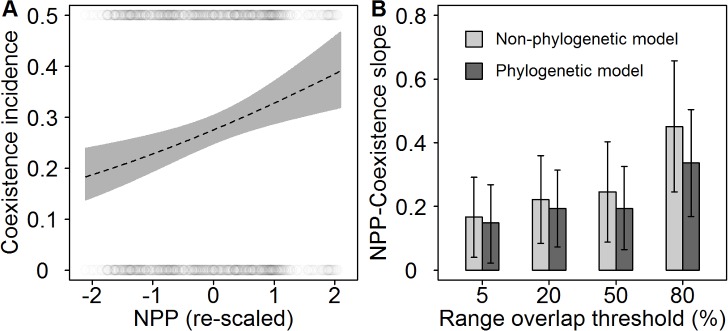
The relationship between (A) coexistence and energy availability (NPP) across sister species pairs is positive and (B) strengthens with the area over which species coexist (as a percentage of the smaller species range). In (A), the dotted black line (and grey 95% confidence interval bands) indicates the predicted probability of coexistence as a function of NPP (standardised to unit variance) and using a threshold of 20% range overlap to define coexistence (S1 Table). Grey circles indicate the observed distribution of sympatric and allopatric sister pairs across the global NPP gradient (N.B. because of the low overall incidence of coexistence, the y-axis is plotted from 0 to 0.5). In (B), bars show estimated slope parameters (and 95% confidence intervals) from a generalised linear model ignoring (light grey) or accounting for (dark grey) species phylogenetic covariance under different coexistence thresholds (S1 Table). See Dryad depository for sister species pairs and plotted data [52].